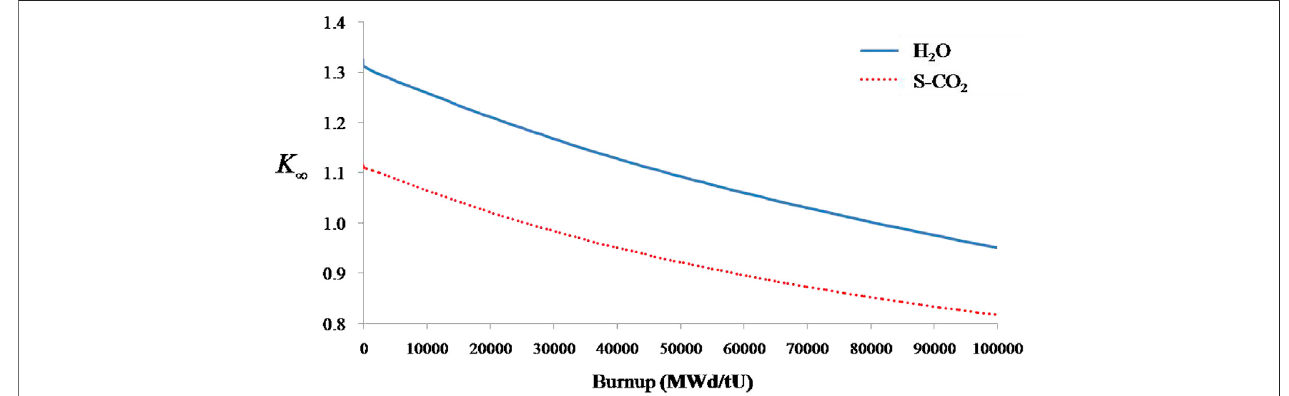
FIGURE 3 | K ∞ versus fuel burn up.